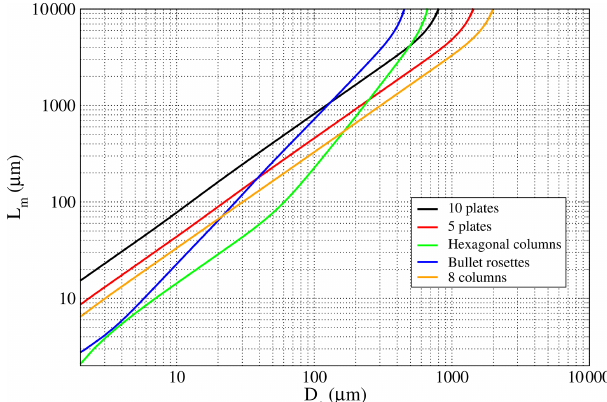
Figure 6. Absolute values of the downwelling spectral radiance derivatives with respect to the effective diameter simulated for two precipitating ice clouds with optical depth 0.5 (a, b) and two (c, d) , at wavenumbers ( ν ) 400cm − 1 (a, c) and 830cm − 1 (b, d) for five different crystal habits.